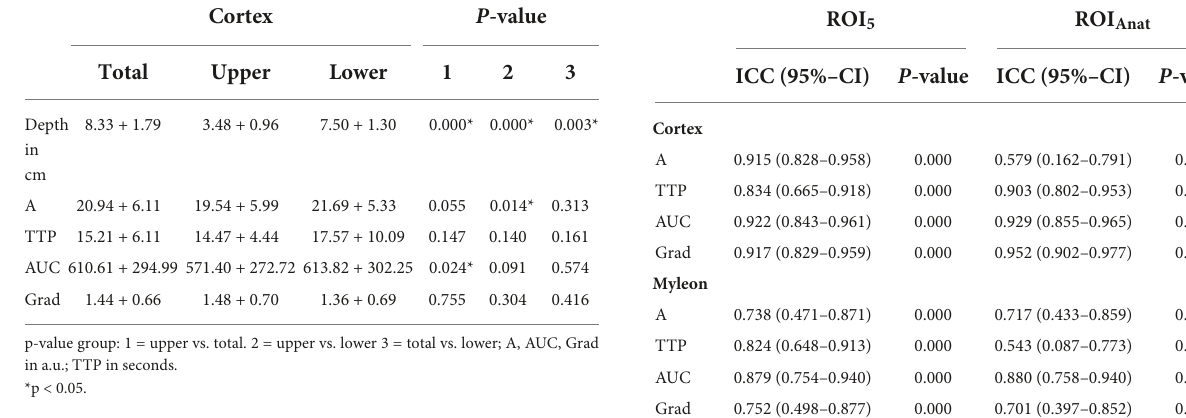
TABLE 6 Impact of depths in ROI Anat on TIC parameter values in the cortex.